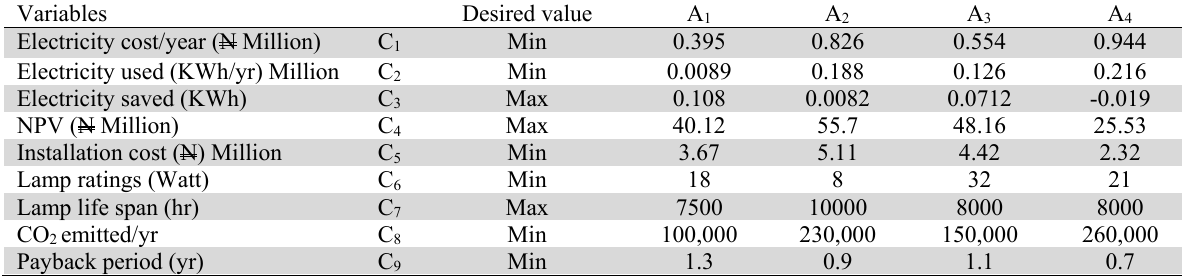
Performance indices of the lighting technologies